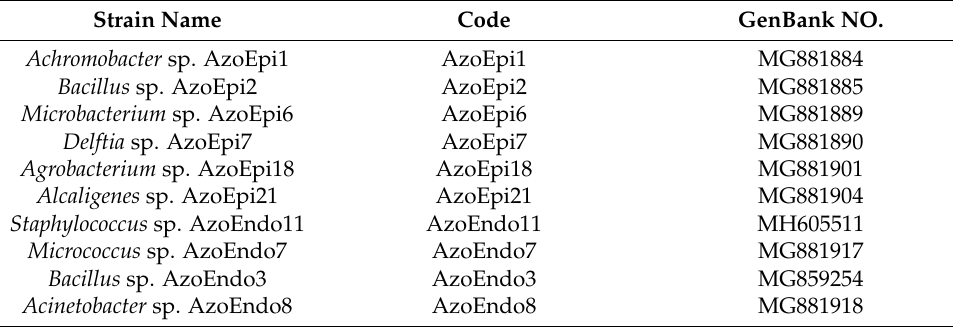
Table 1. Strains selected for the study and their accession numbers from the GenBank database